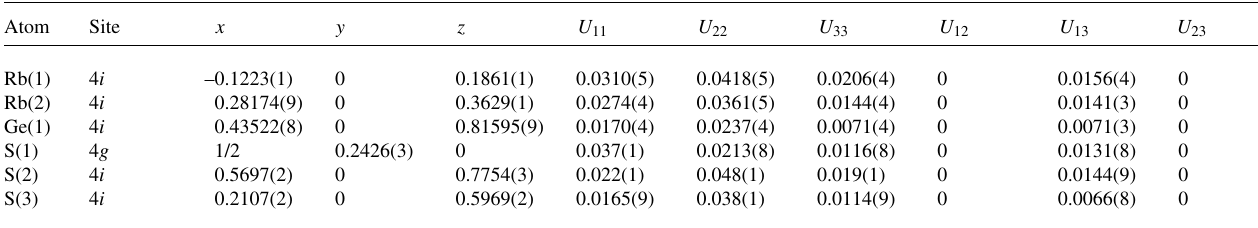
Table 2. Atomic coordinates and displacement parameters (in Å 2 )